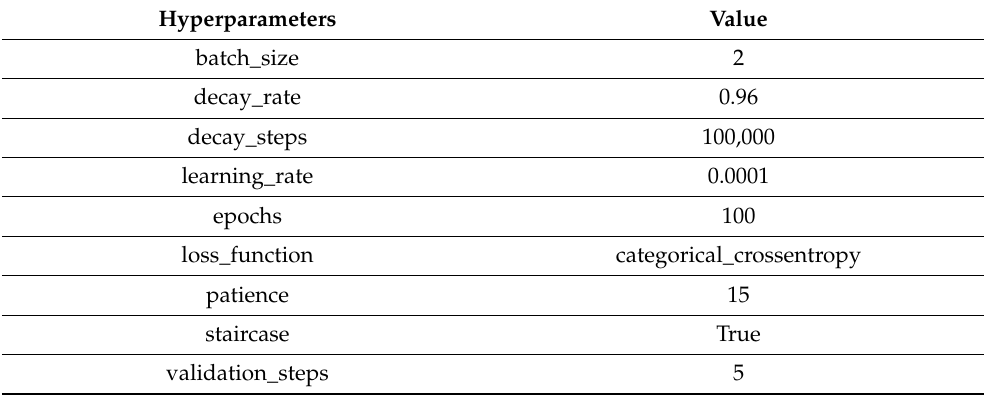
Table 5. Standard hyperparameter configuration used in all